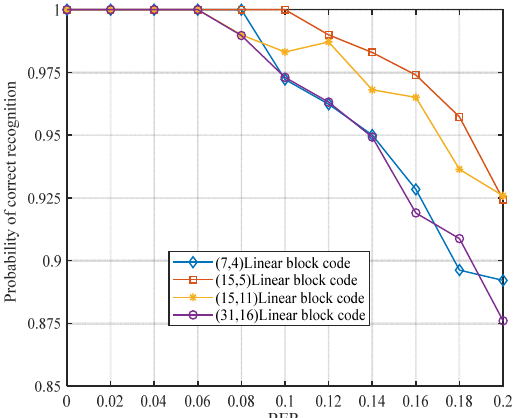
Figure 11. Influence of linear block code parameters on the recognition rate.